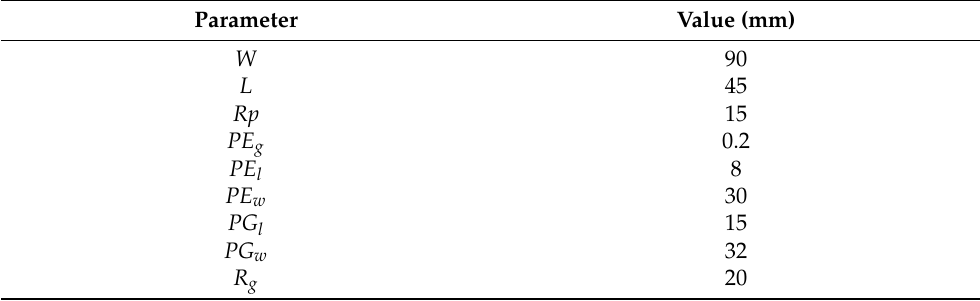
Table 2. Geometrical